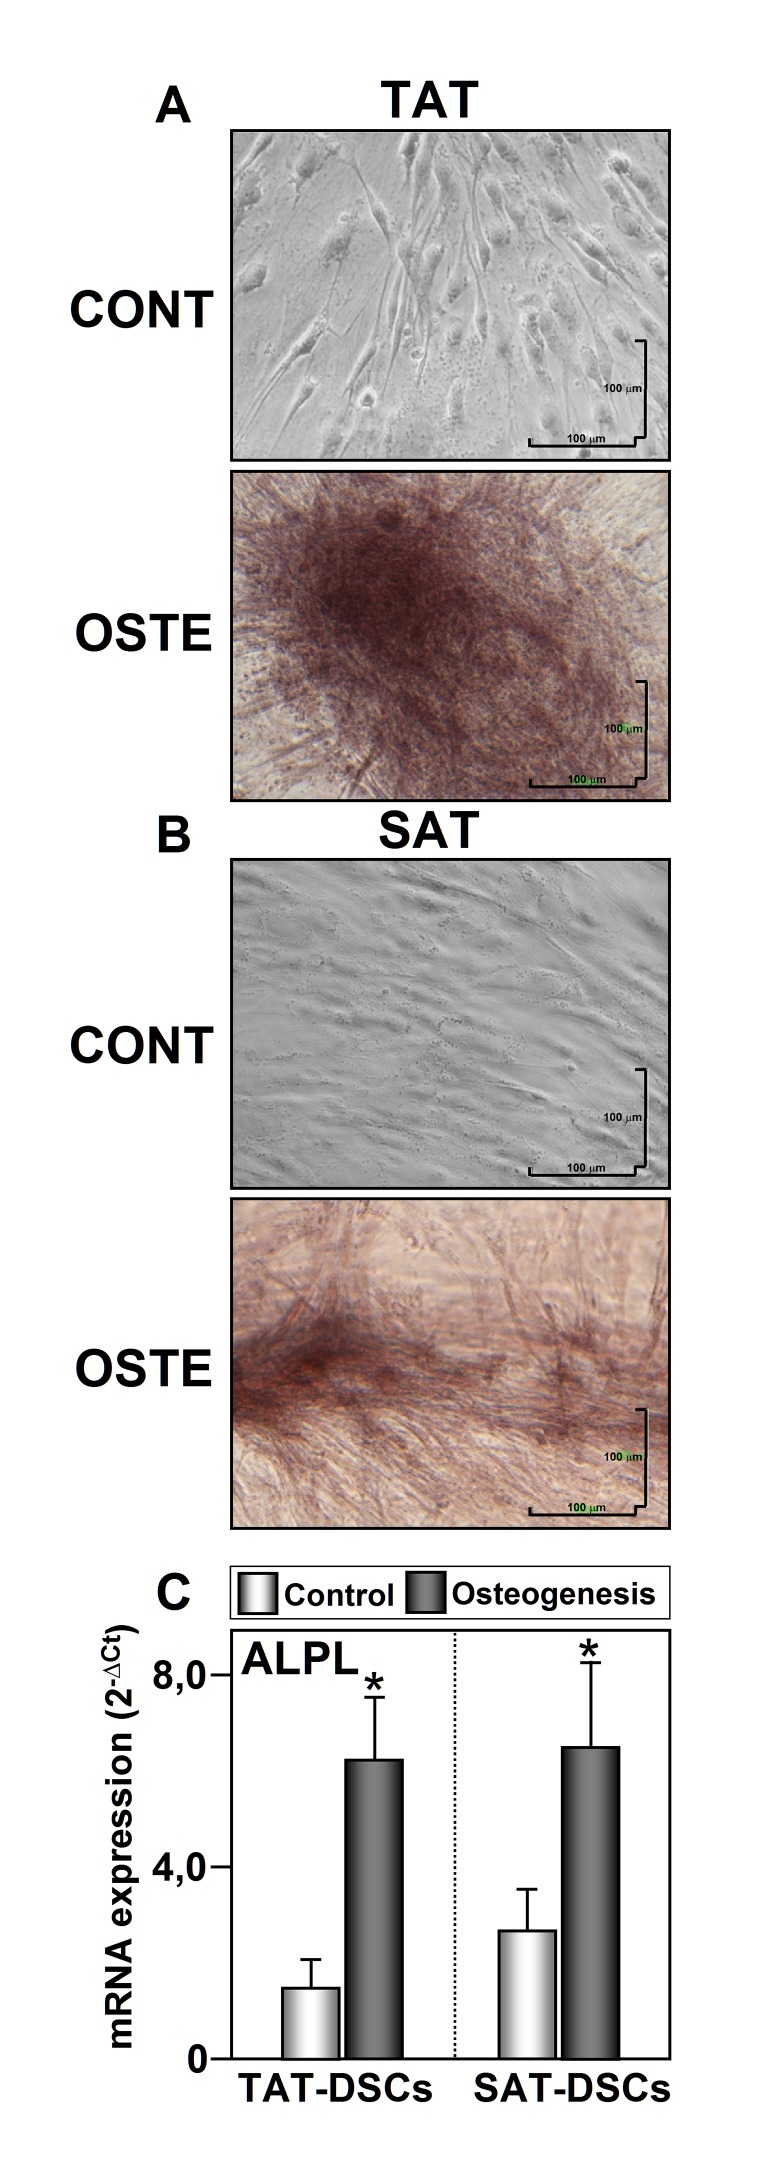
Osteogenic differentiation of human thymus and subcutaneous adipose tissues derived stromal cells (TAT-ASC and SAT-ASC).Representative photomicrographs of cells obtained from thymus fat (TAT-ASCs) (A) and from subcutaneous adipose tissue (SAT-ASCs) (B) (n = 26) grown in osteogenic medium for 14 days. Osteogenic differentiation of ASCs was confirmed by detecting calcium deposition by Alizarin Red S staining. (C) Osteogenic process confirmation was carried out by mRNA expression analysis of the osteogenic marker ALPL. mRNAs were normalized to cyclophilin expression levels. Each sample from each subject was analyzed separately and in triplicate. Data represent the mean ± SEM of the values obtained from all samples. The relationship between control and osteogenic differentiation was analyzed by range test with Wilcoxon sign. *p<0.05. Image magnification is 20X.